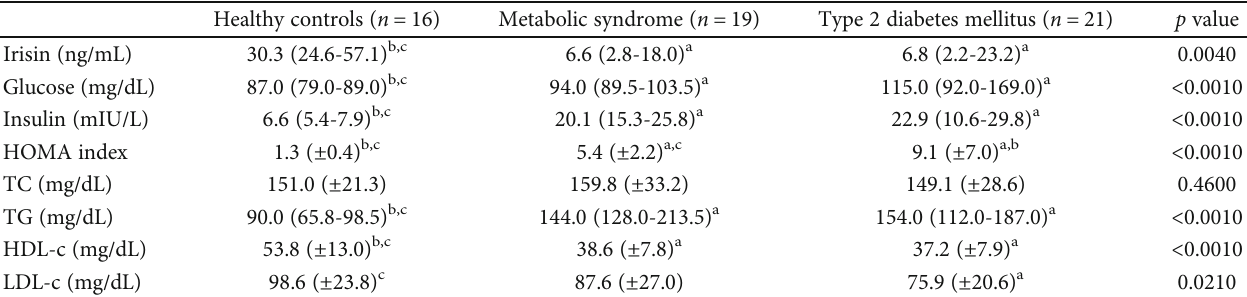
Table 2: Biochemical parameters in children and adolescents with type 2 diabetes mellitus, metabolic syndrome, and healthy